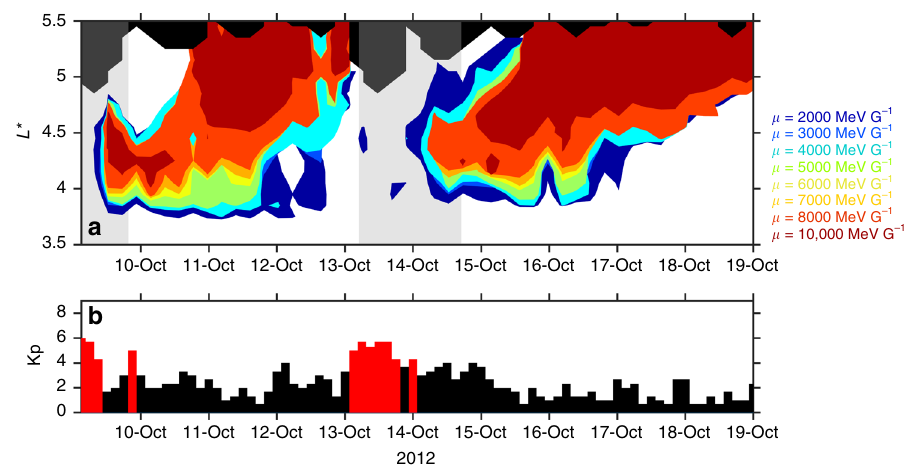
Fig. 4 Evolution of the L *-coverage of phase space density enhancements during October 2012. In ( a ), contours show the L * extent of phase space density values that are within half an order of magnitude of the maximum phase space density for the period (at a speci fi c value of μ ranging from 2000 to 10,000MeV G − 1 ). To form the contours, the phase space density values (Supplementary Fig. 2) were binned into 5-h intervals and by 0.1 L *. By layering these contours for different values of μ , acceleration regions over a broad energy range are revealed. L * values not sampled by the Van Allen Probes are shown in black. The phase space density pro fi le shows a peaked pro fi le between L * ≈ 4.0 – 4.5, at which μ = 8000 and 10,000 MeV G − 1 correspond to ~5.4 – 6.5 and ~6.0 – 7.3 MeV, respectively (see Fig. 2). The K p index, shown in ( b ), provides a measure of geomagnetic activity and is derived from ground magnetometer measurements. K p < 4 is shown as black bars and K p ≥ 4 as red bars to highlight periods of geomagnetic